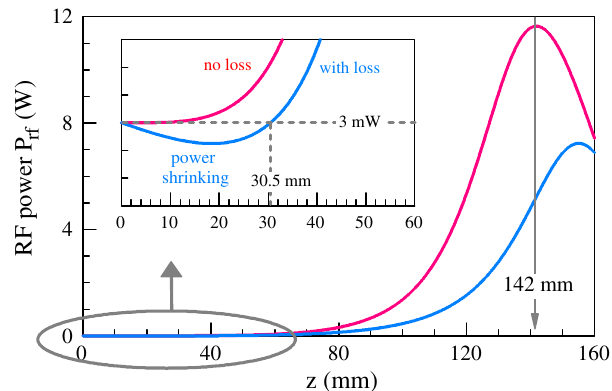
FIG. 8. (Color) Dependence of rf power P with a lossy circuit, compared with the one with a loss-free circuit. The flowing rf power shrinks in the initial part because of the circuit